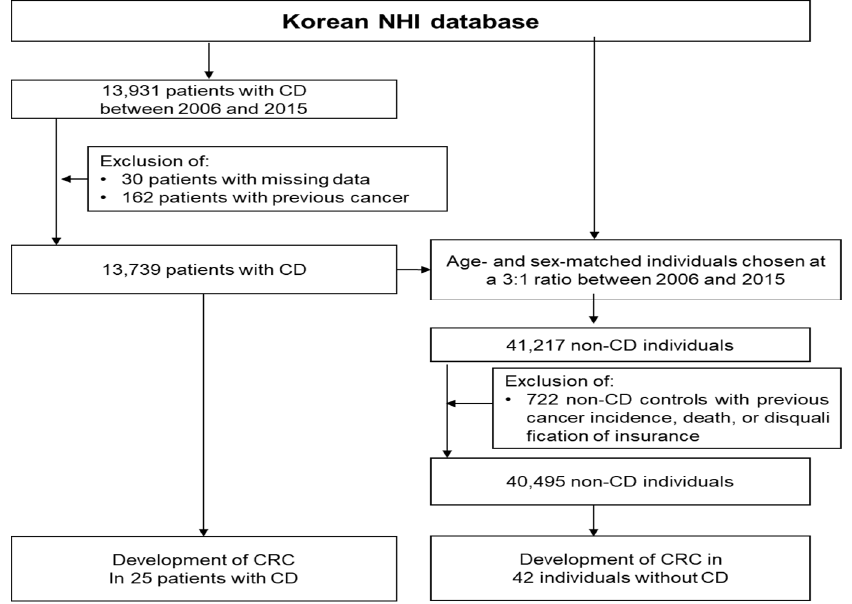
Figure 1. Flow chart of the study population. NHI, National Health Insurance; CD, Crohn’s disease; CRC, colorectal cancer.